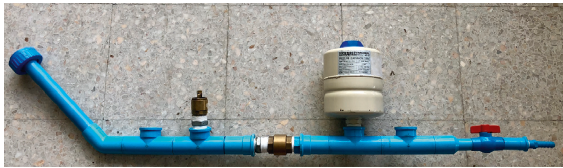
Figure 7: HRP body with diaphragm